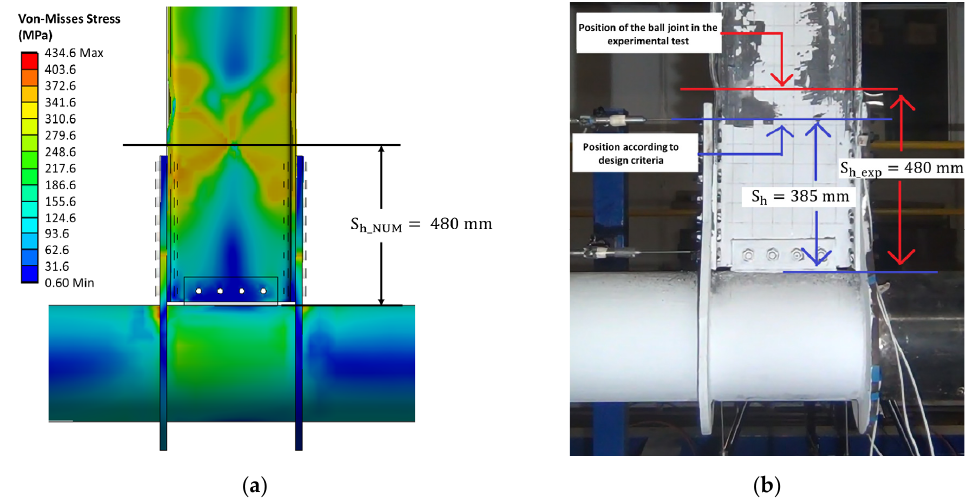
Figure 10. ( a ) plastic hinge location and ( b ) comparison with the observations obtained experimen- Figure 10. ( a )plastichingelocationand( b tally [19].